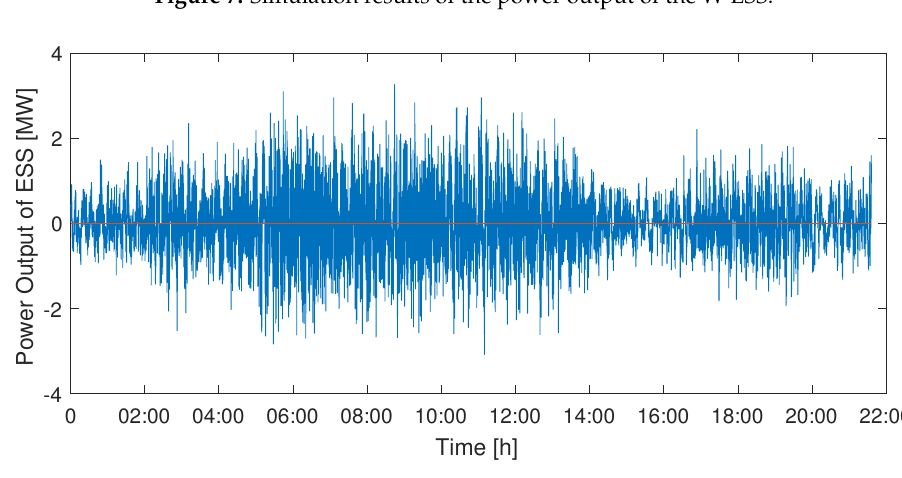
Figure 7. Simulation results of the power output of the W-ESS.